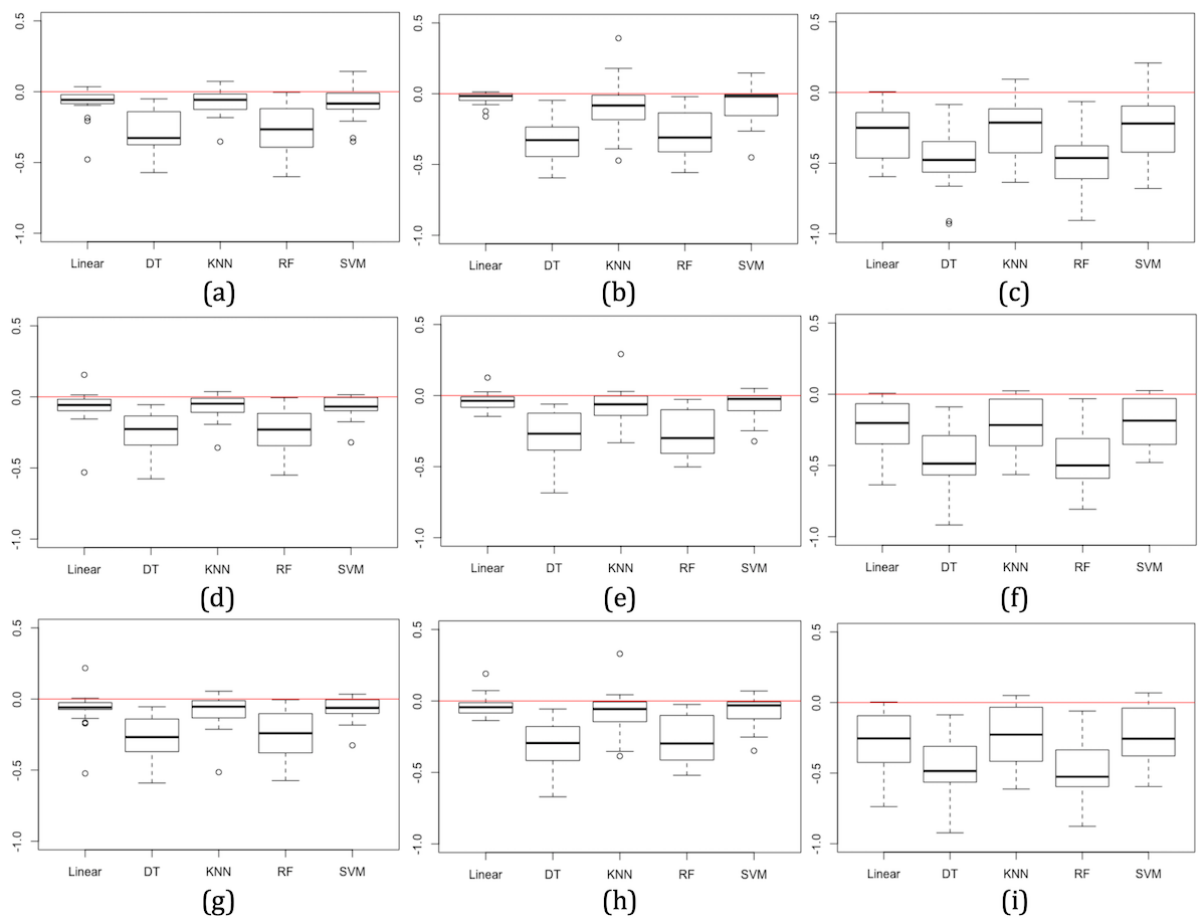
Figure 4. Overall change in precision (a-c), recall (d-f), and F1 (g-i) scores for each machine learning model when trained on synthetic data (from 19 datasets) generated using classification and regression tree (a, d, g), parametric (b, e, h) and Bayesian network (c, f, i) approaches, compared with models trained using real